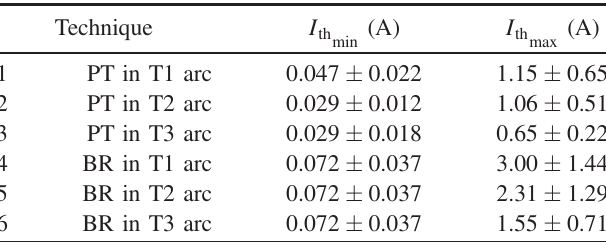
TABLE IV. Effectiveness of different BBU mitigation tech- niques in MESA.